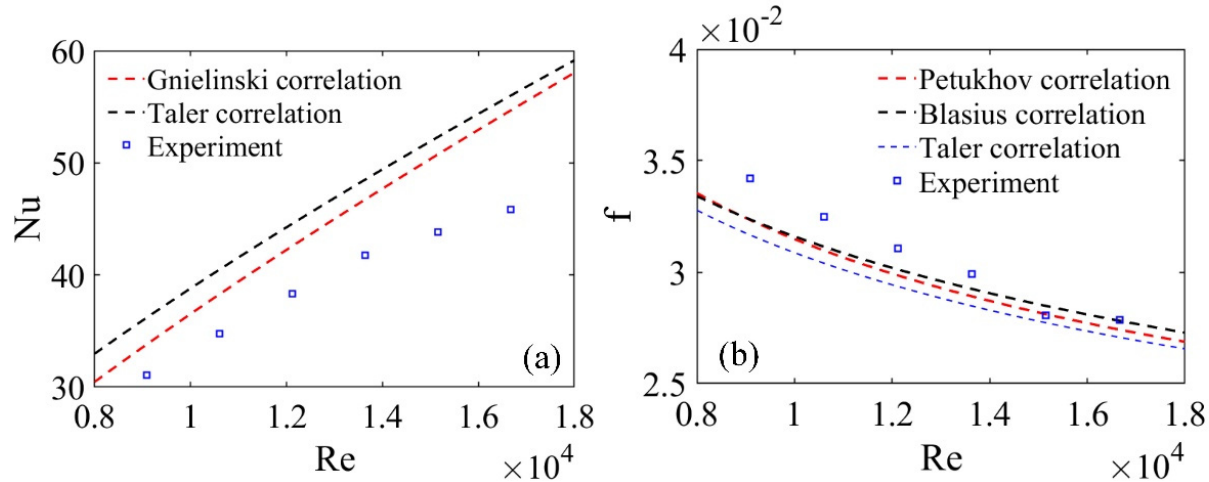
Figure 6. Verification of the smooth tube: ( a ) nusselt number, ( b ) friction factor.